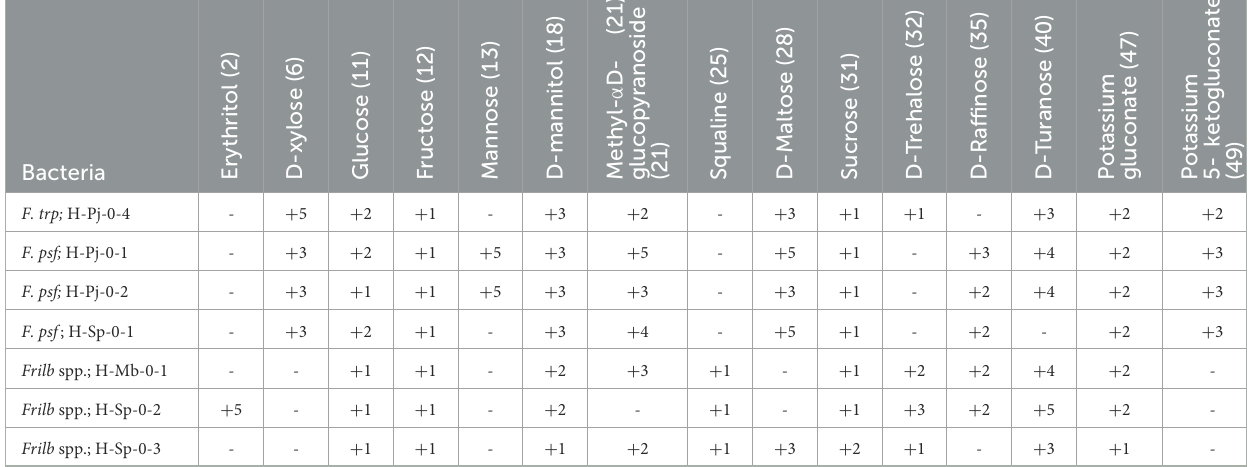
FIGURE8 Optical microscope micrograph of the Fructobacillus pseudoficulneus H-Sp-0-1.